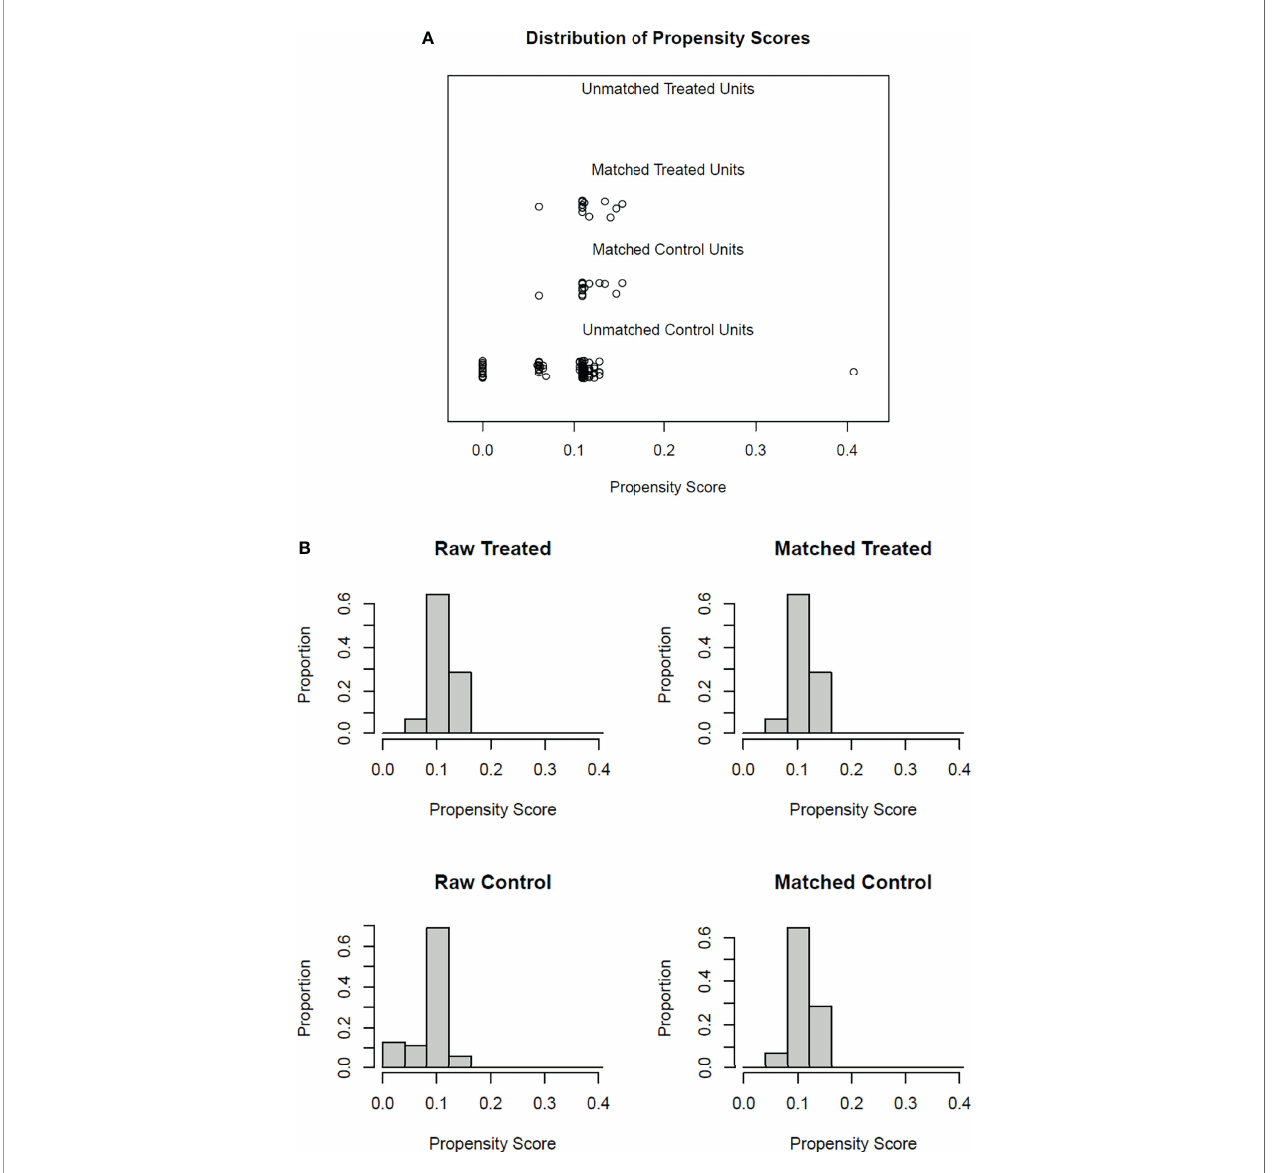
FIGURE 1 | Propensity score matching diagnostic plots. Panel (A) jitter plot of propensity scores. The middle lines show the close match between the randomly selected treatment units and the matched control units. The bottom line shows the unmatched control units not included in the analysis. Panel (B) Histogram distribution before and after the matching